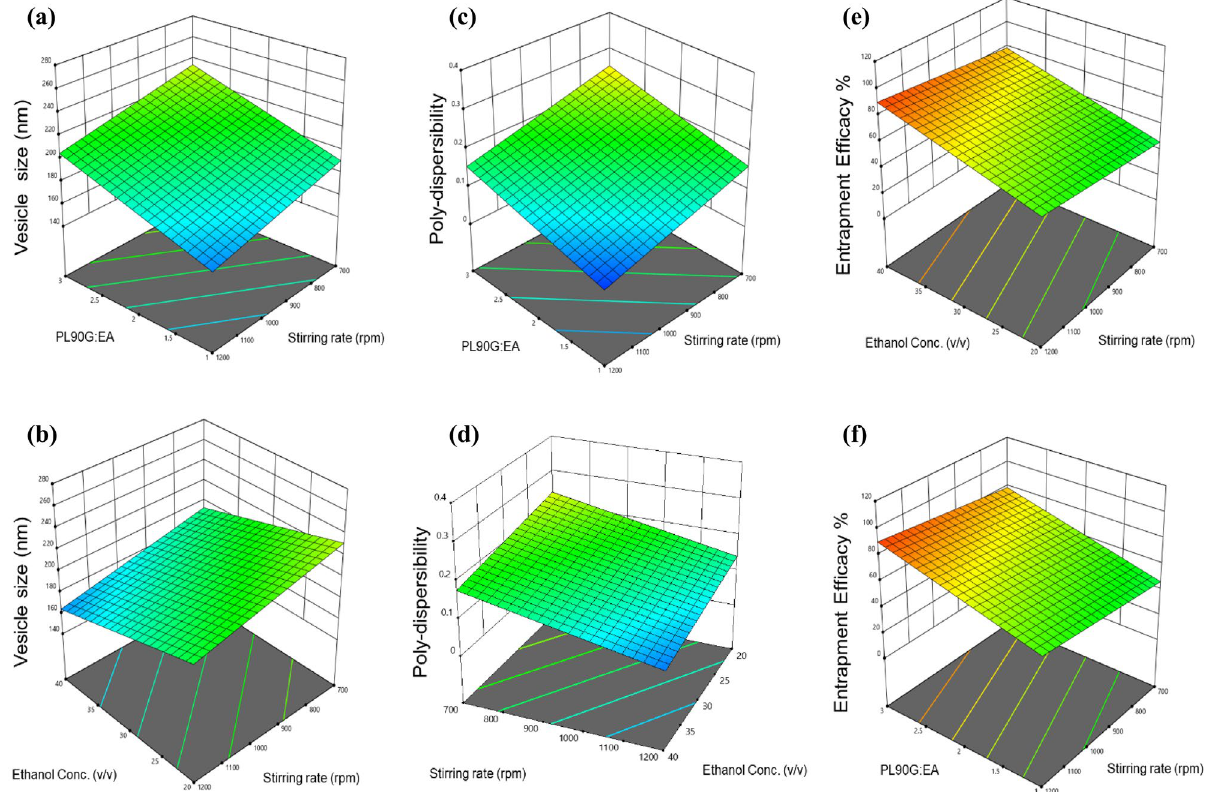
Figure 3. Surface (3-D) plots exhibiting the effects of independent variables upon the response factors; ( a ) effect of PL90G:EA ratio and stirring rate over the vesicle size; ( b ) effect of ethanol conc. and PL90G:EA on vesicle size; ( c ) effect of PL90G:EA ratio and stirring rate over the PDI; ( d ) effect of ethanol conc. and PL90G:EA on PDI. ( e ) Effect of ethanol conc. and stirring rate on the %EE; ( f ) effect of PL90G:EA and stirring rate on the